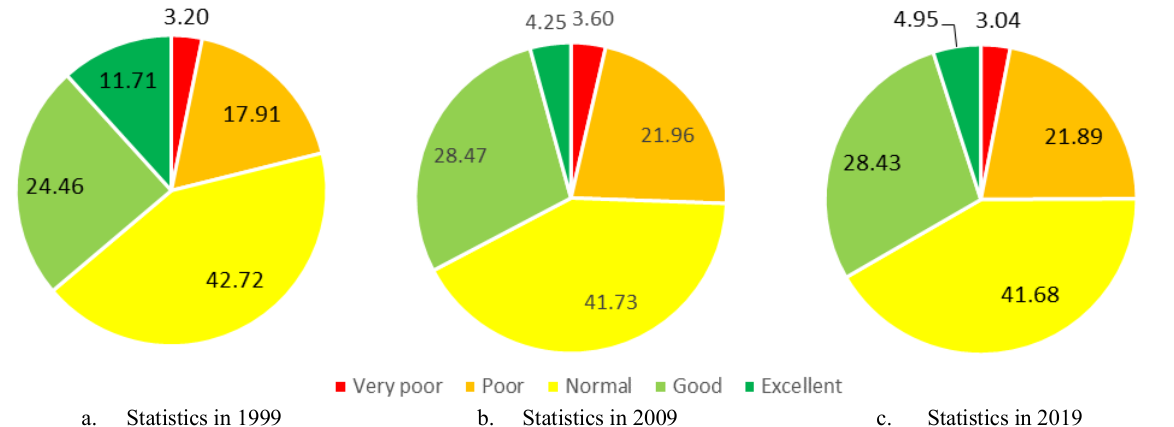
Figure 3. Relative area of each eco-environmental quality class related to the total area of Anqing city in 1999, 2009, and